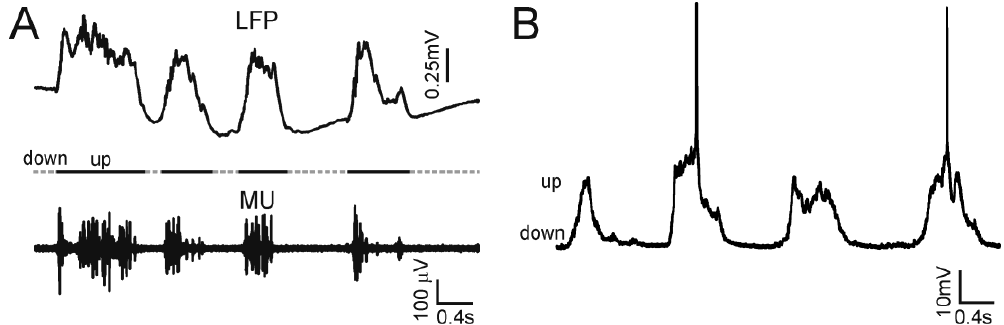
FIGURE 1. UP- and DOWN-state transitions during slow oscillation activity. (A) Extracellular local field potential (LFP, top) and multiunit (MU, bottom) recordings showing slow oscillations in the neocortex of urethane-anesthetized mice. Note the recurrent transitions from the UP to the DOWN state at low frequency (<1 Hz). Action potential firing (see MU trace) occurs synchronously among different cortical neurons only during the UP state. (B) Patch-clamp, current-clamp recording from a cortical neuron in vivo showing membrane potential changes during slow